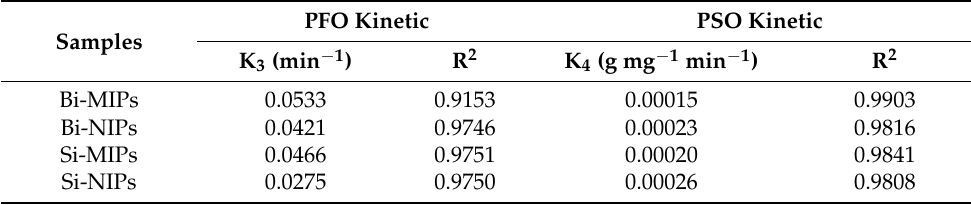
Table 2. Kinetic data of the PFO and PSO kinetic models.